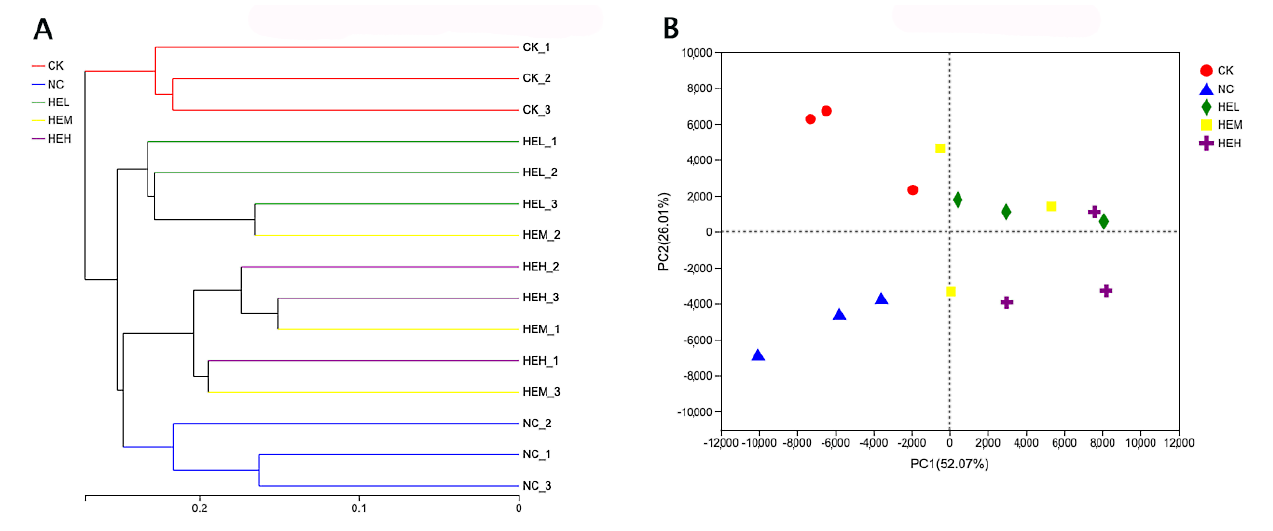
Figure 8. ( A ) Hierarchical clustering. ( B ) Principal Coordinates Analysis (PCoA) of different sam- ples.